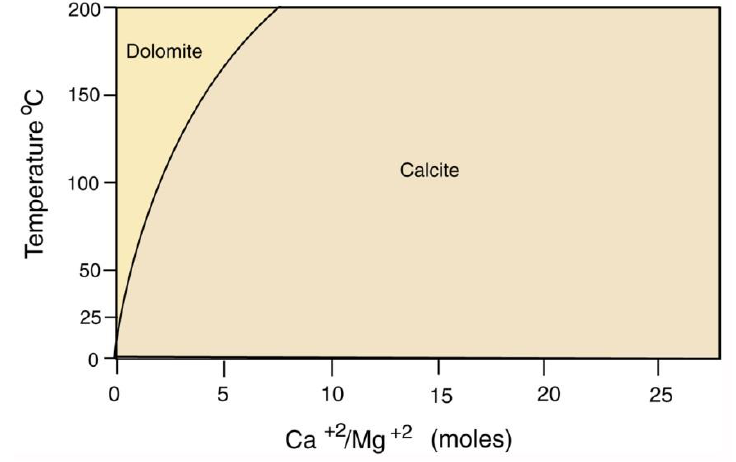
Figure 33. Precipitation of calcite and dolomite, pH = 7. Data adapted from [83].